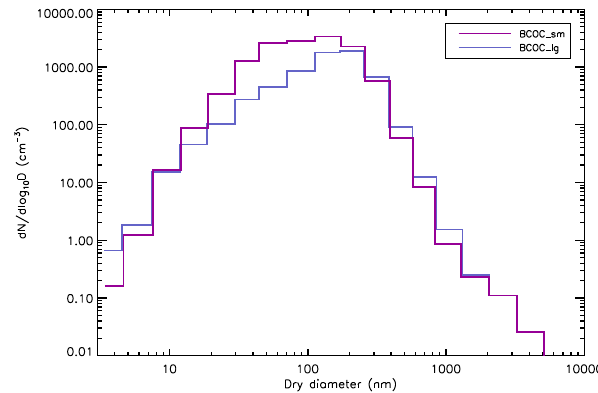
Fig. 3. Campaign-mean modelled total number size distribution averaged over all ground sites in Table 1. Model experiments, BCOC sm and BCOC lg, are described in Table